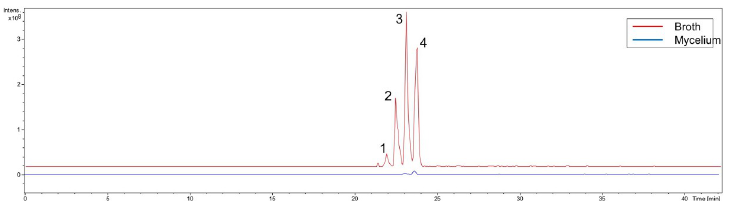
Fig 3. Extracted-ion chromatogram from LC-MS analyses of broth (red) and mycelium (blue) extracts (SCB medium– 7 days). Surugamides: 1 at 22.0 min, 871.1 Da; 2 at 22.4 min, 885.1 Da; 3 at 22.9 min, 899.1 Da; 4 at 23.5 min, 913.1